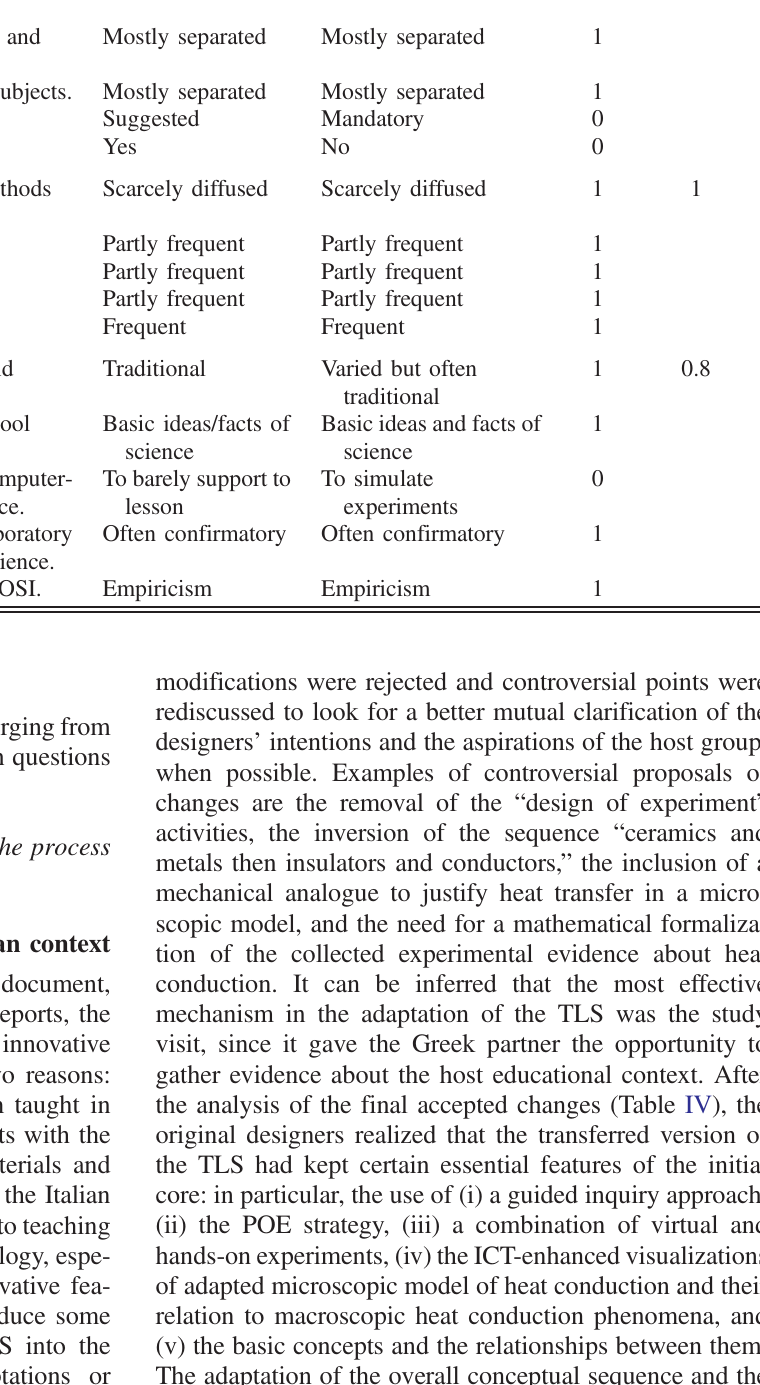
TABLE VI. Analysis of the institutional distance between Italy and Greece.